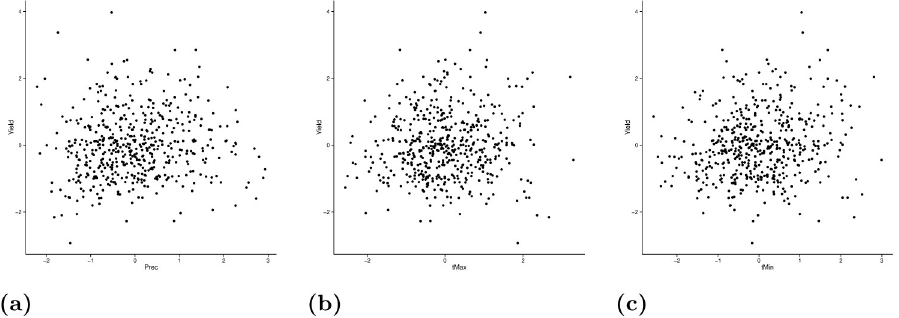
Fig 1. Annual standardized yield and precipitation (a), maximum temperature (b), and minimum temperature (c), using maize data in Eastern Africa (1961–2002).